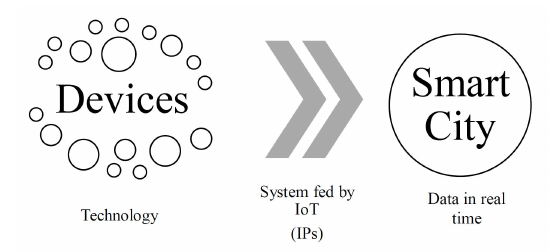
Figure 8. Towards smart